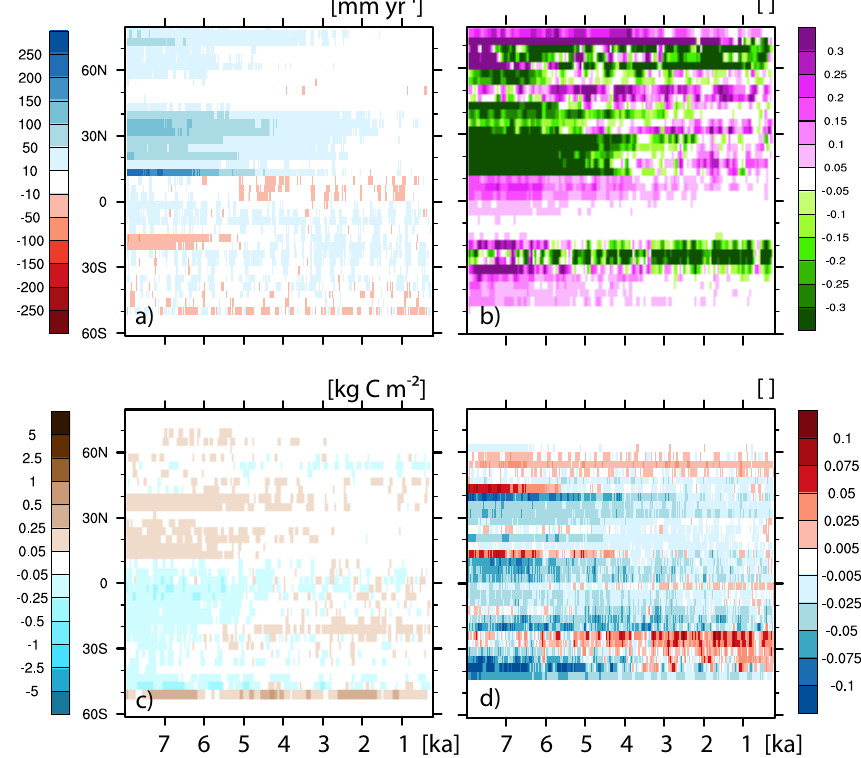
Fig. 2. Transient anomalies of latitudinal averaged values (over land) for (a) yearly precipitation [mmyr − 1 ], (b) desert fraction [m 2 m − 2 ], (c) carbon stored in green biomass [kgCm − 2 ], and (d) fraction of burned area [m 2 m − 2 ]. The base period for calculating all anomalies is pre-industrial climate (PI).